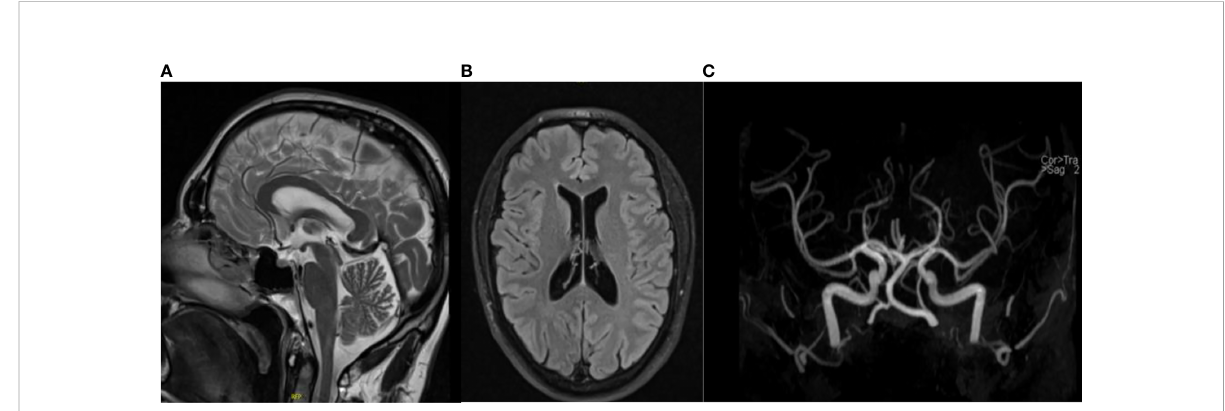
FIGURE 3 Magnetic resonance imaging depicting T2 fl air (A) and coronal (B) and TOF angiography (C) views of the brain, excluding cerebral hemorrhages and